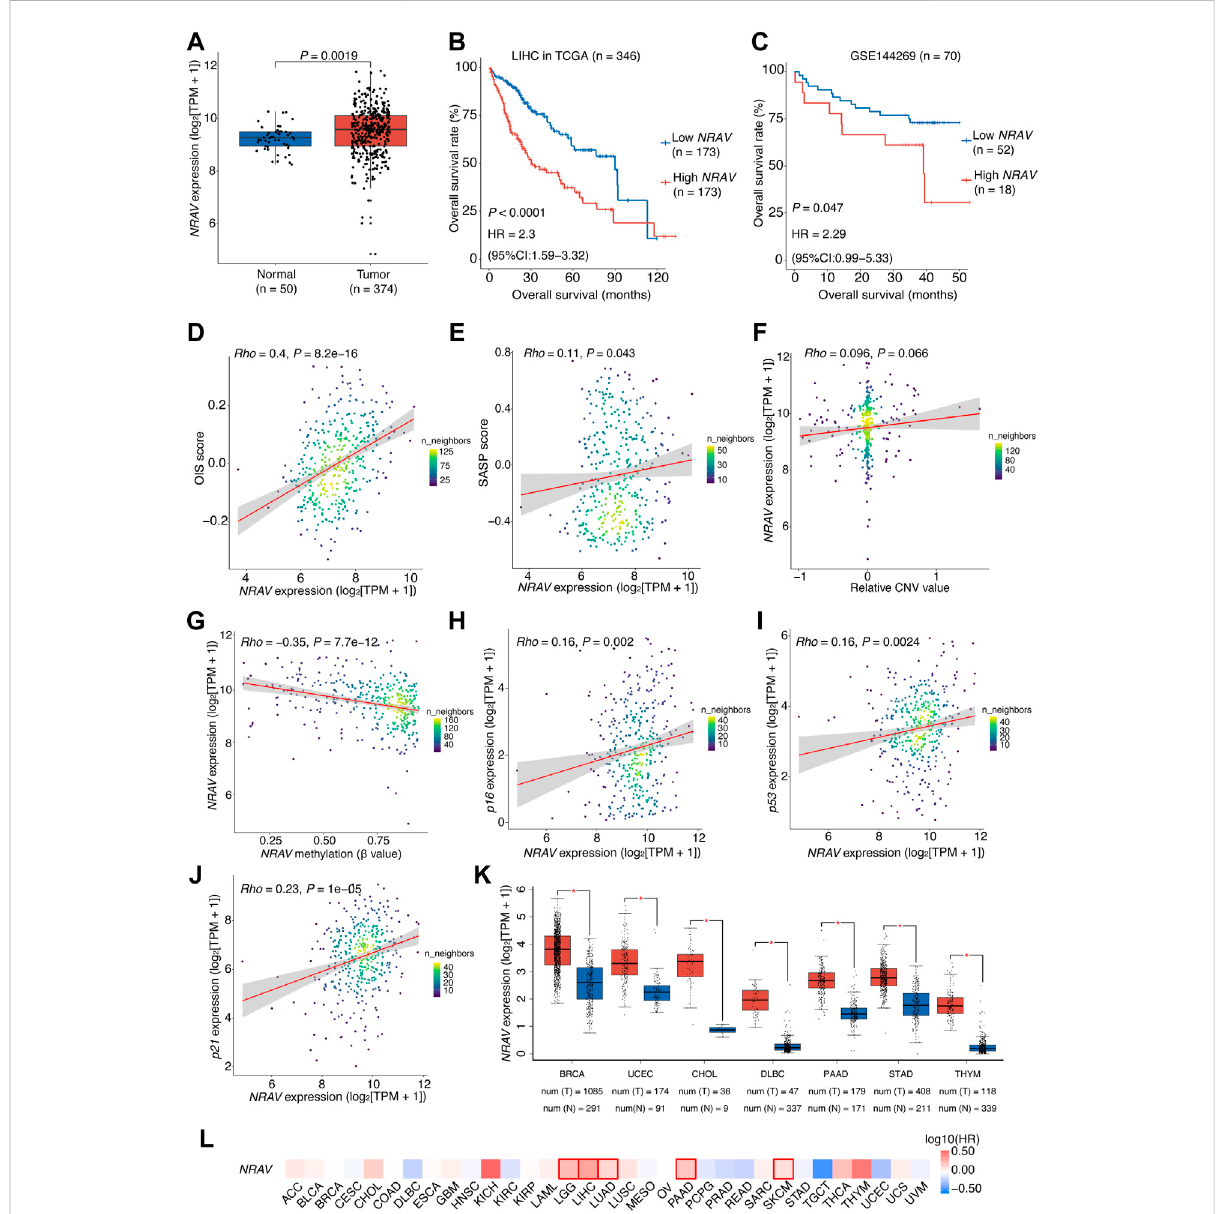
FIGURE 7 Over-expressionof NRAV drivenmainlybyDNAhypomethylationisassociatedwithpoorprognosisofHCCpatients. (A) NRAV expressionlevels inthehigh-andlow-riskgroups.Wilcoxtestwasusedtogetthe p value. (B) Kaplan-MeiersurvivalplotsofHCCpatients(TCGA-LIHC)groupedbythe expression of NRAV (strati fi edby themedian expression). (C) Kaplan-Meier survival plotsof HCC patients (GSE144269) grouped bythe expressionof NRAV (strati fi edbytheupperquartileexpression). (D) A scatter plotofthecorrelationbetween NRAV expressionandtheOISscore. (E) A scatter plotofthecorrelationbetween NRAV expressionandtheSASPscore. (F) AscatterplotofthecorrelationbetweentherelativeCNVvalueof NRAV and its expression. (G) A scatter plot of the correlation between the DNA methylation level of NRAV and its expression. (H – J) Scatter plots of the correlations between expression of NRAV and senescence-associated markers, including p16 , p21 and p53 . (K) Expression levels of NRAV in tumors and adjacent non-tumor tissues across different cancer types. The data was collected from GEPIA. ( L ) Survival analyses of NRAV expression in TCGA pan-cancer cohorts. The HRs and p values were calculated using univariate Cox proportional hazards regression analysis. In (B,C) , The p value was determined by log-rank test, and the HR with 95% CIs were obtained from multivariate Cox proportional hazards regression analysis. In (D – J) , the correlation coef fi cients ( rho ) and p values were calculated using Spearman rank correlation analysis and the color represents the density of the scatters. HCC, hepatocellular carcinoma; HR, hazards ratio; CI, con fi dence interval; CNV, copy number variation; TCGA, the cancer genome